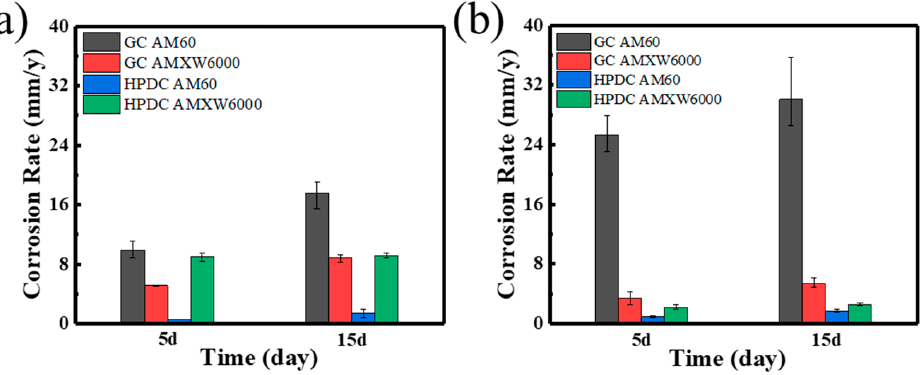
Figure 9. Corrosion rate examined by weight loss tests of GC and HPDC samples: ( a ) IT and ( b ) SST results, respectively. Table 2. Corresponding weight loss results in Figure